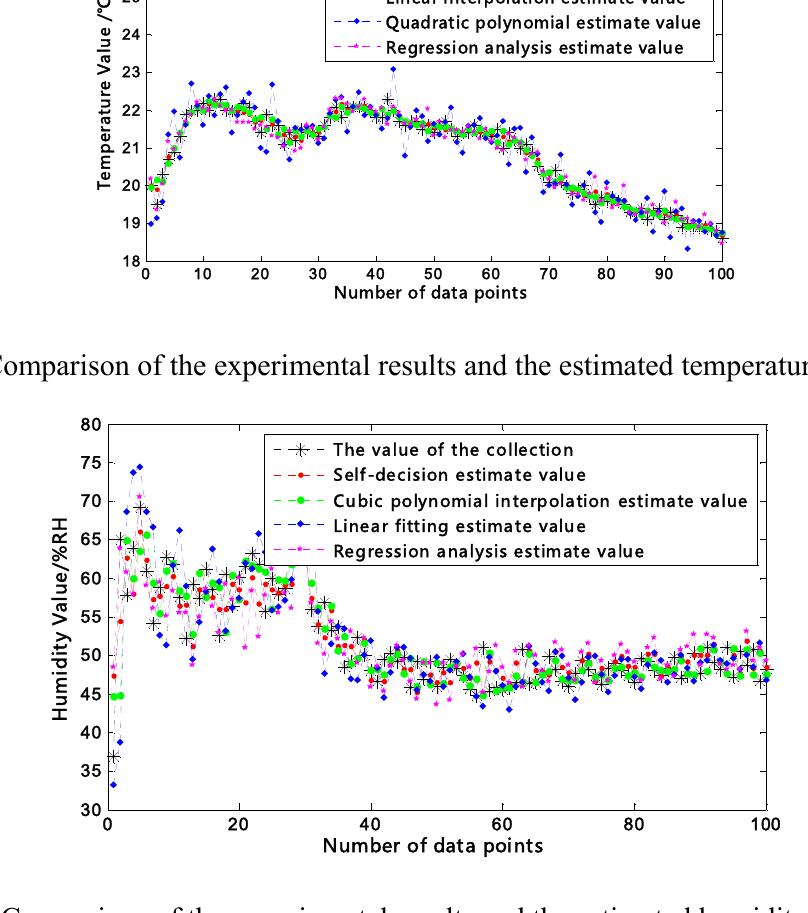
Figure 8. Comparison of the experimental results and the estimated humidity of Node A.